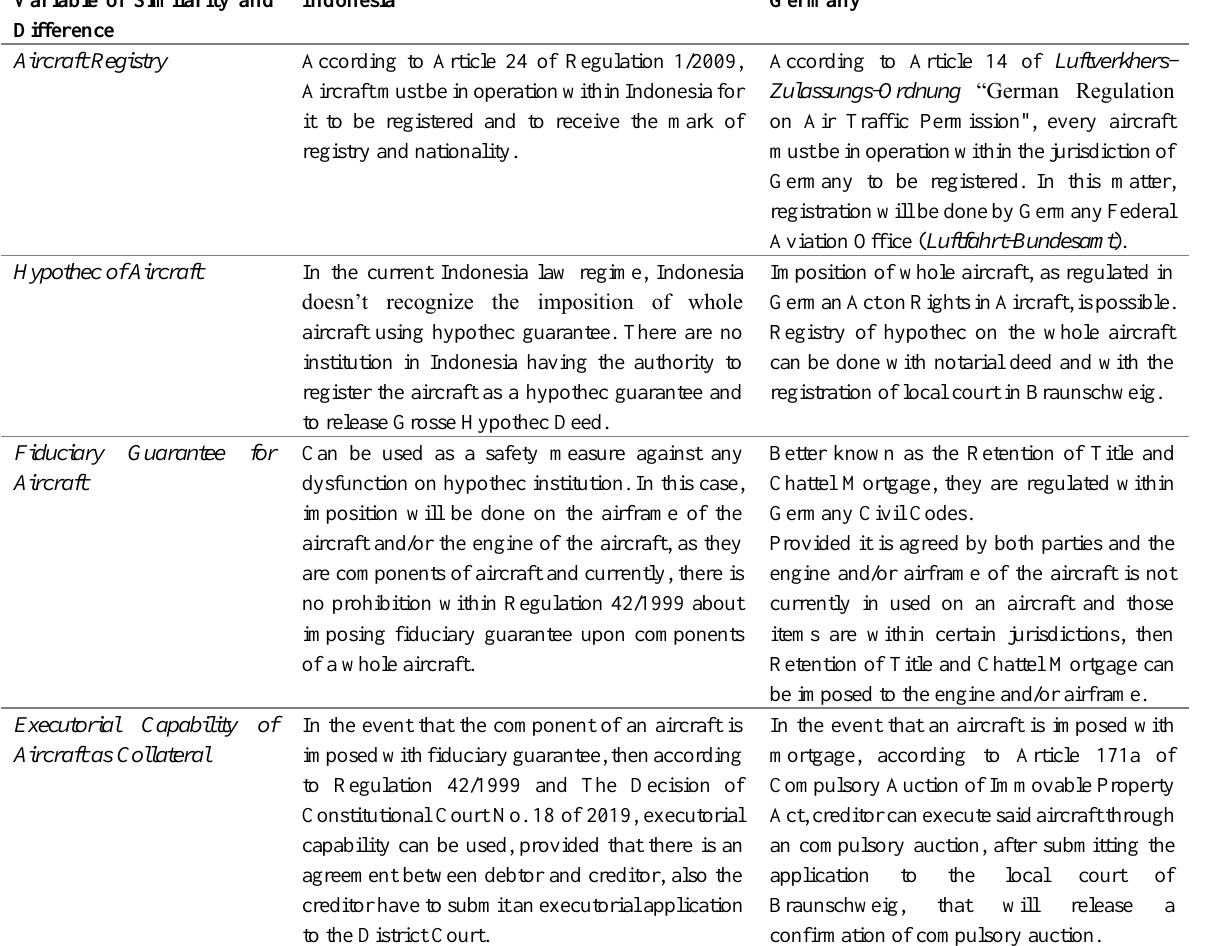
Table 1: Comparison of Landscape of Regulations in Indonesia in Indonesia and